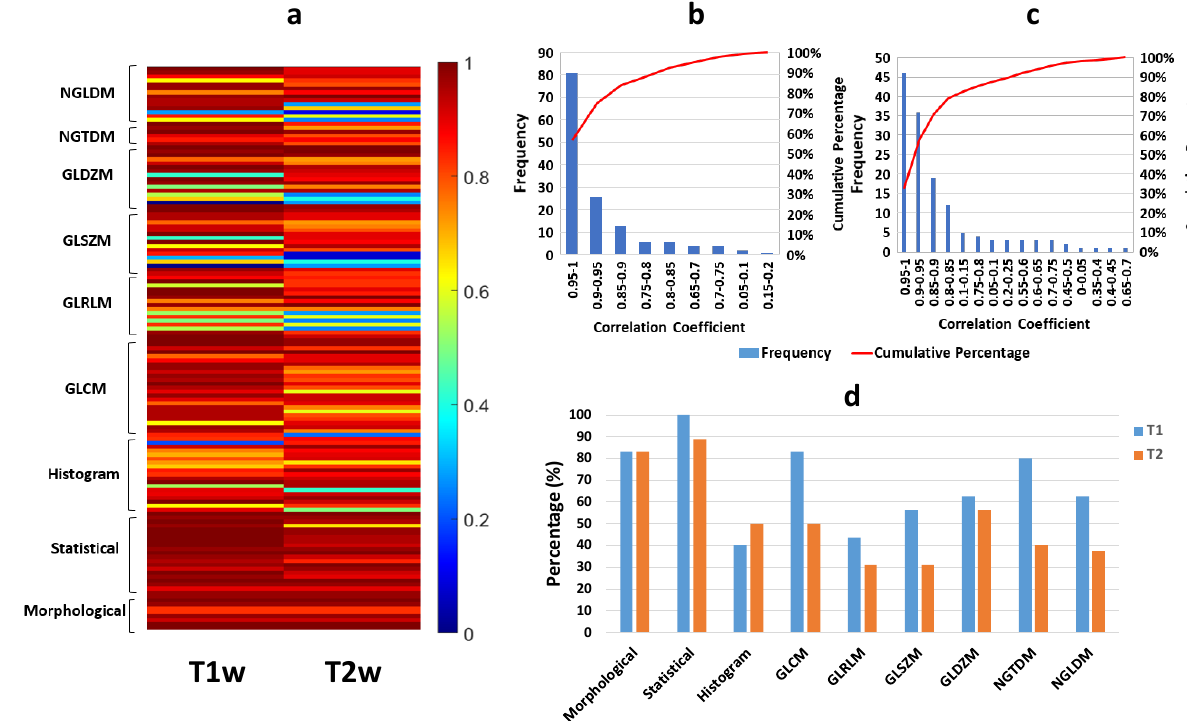
Figure 5. ( a ) Heatmap depicting the SCC between the radiomic features extracted from the D-R2UNet segmentation maps and the STAPLE-generated maps (ground truth) grouped by radiomic sub-category for T1w and T2w, ( b ) frequency of SCC between STAPLE and D-R2UNET for T1w, along with the cumulative sum percent of features in each binning range, ( c ) frequency of SCC between STAPLE and D-R2UNet for T2w, along with the cumulative sum percent of features in each binning range, ( d ) percentage of radiomic features that are highly correlated, i.e., ρ ≥ 0.9 ( p ≤ 0.05) grouped by feature sub -category.